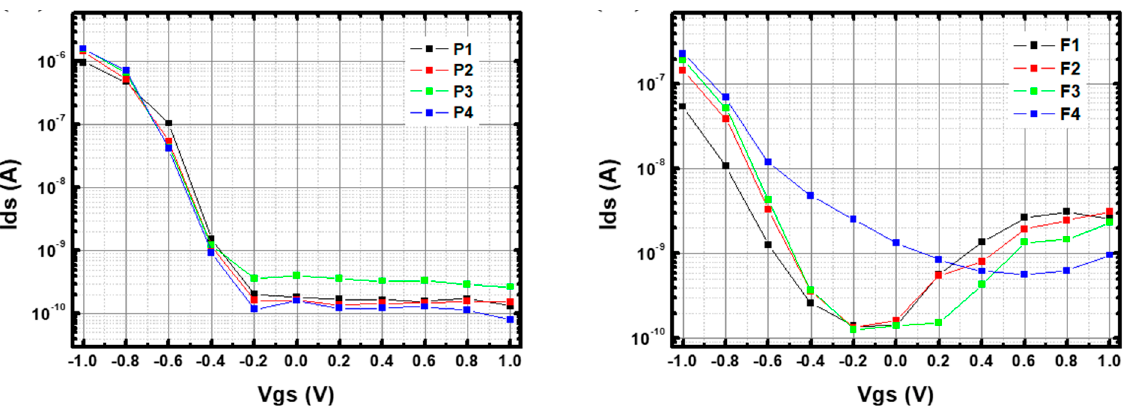
Figure 6. I–V transfer curve of ( left ) p-CNTFETs and ( right ) f-CNTFETs in phosphate buffer solution (PBS) at pH 7. All transistors were 5 µ m channel devices. V ds is set to +0.8 V and V gs was swept from − 1 V to +1 V. A logarithmic scale is used for the vertical axis.